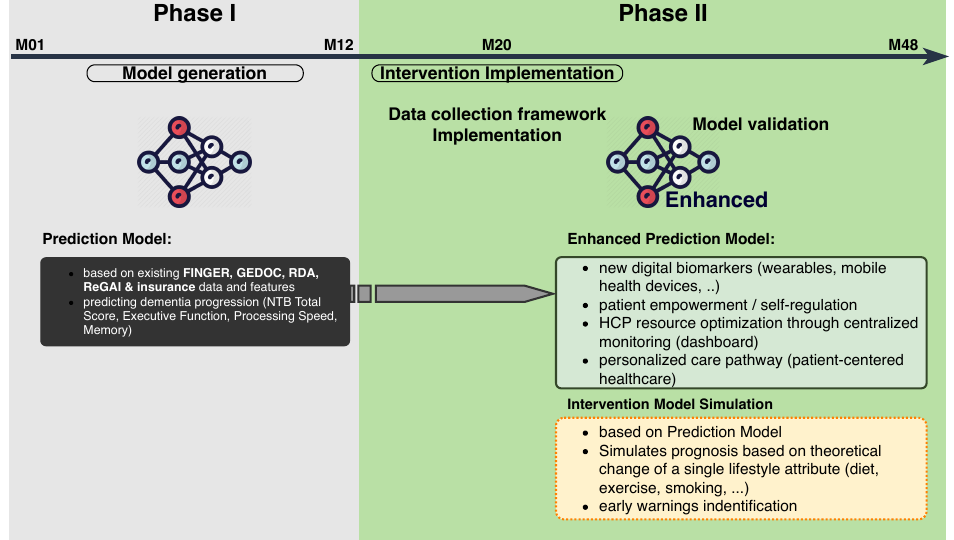
Figure 3. Two phases of the LETHE model implementation: Phase I—model generation based on retrospective data; Phase II—model extension and model